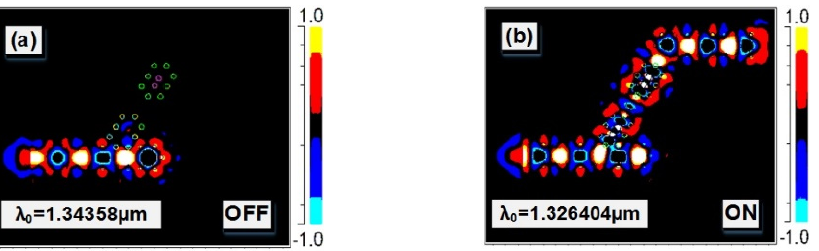
Figure 7. ( a ) Sensor performance in the passive mode, resonant wavelength λ 0 = 1.34358 nm. ( b ) Sensor function inactive mode, resonant wavelength λ 0 = 1.326404 nm.